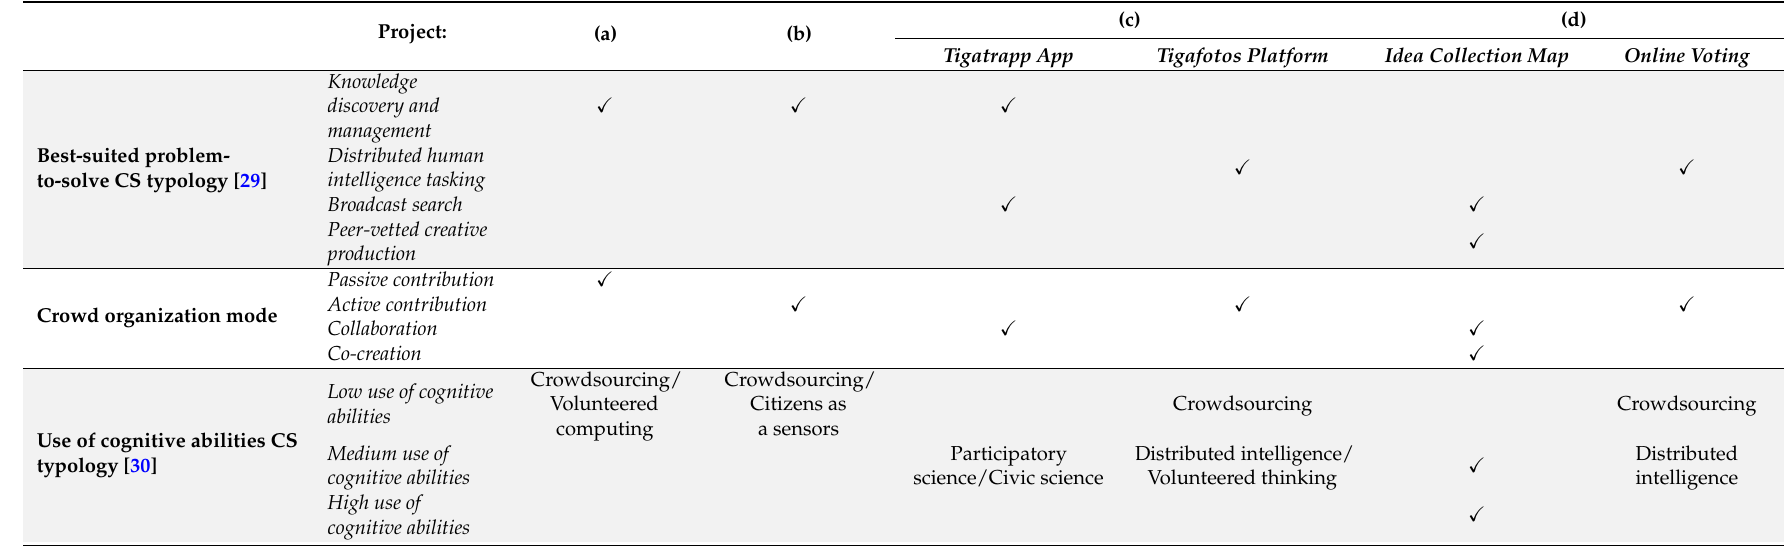
Table 5. VGI Project Planning—Crowdsourcing